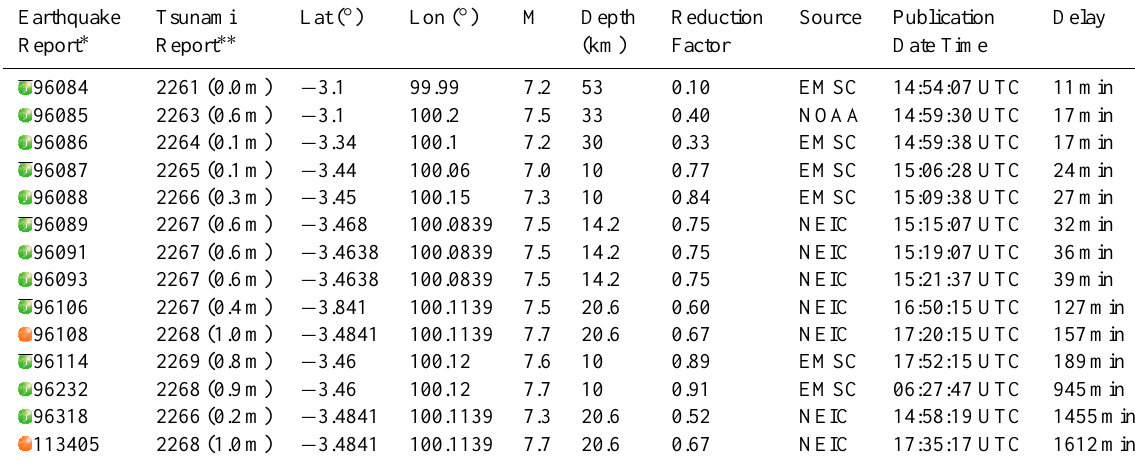
Fig. 7. Tectonic setting of the region (McCaffrey, 2009). Table 3. The timeline of the preliminary earthquake parameters pushed to the GDACS system on 25 October 2010 (GDACS, 2010b).